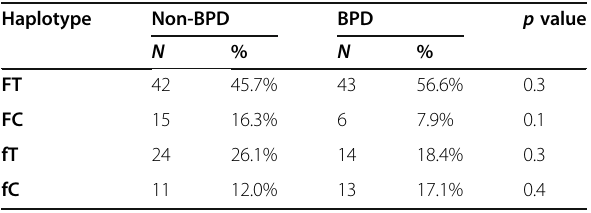
Table 4 Combined Taq1 and Fok1 haplotype frequencies among cases and controls Haplotype